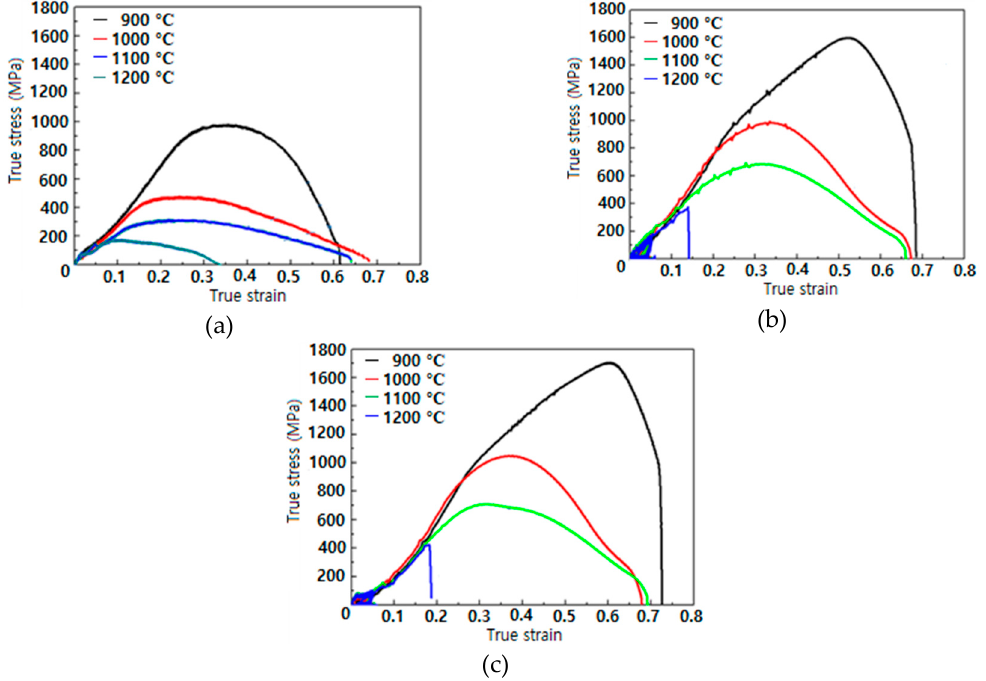
Figure 5. True stress-true strain curve obtained by tensile tests at different temperatures and strain rates: ( a ) 0.1 s − 1 strain rate, ( b ) 10 s − 1 strain rate, ( c ) 30 s − 1 strain rate